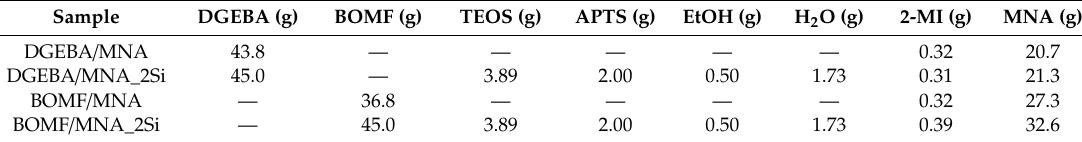
Table 2. Acronyms and batch compositions of the epoxy and epoxy / silica hybrids